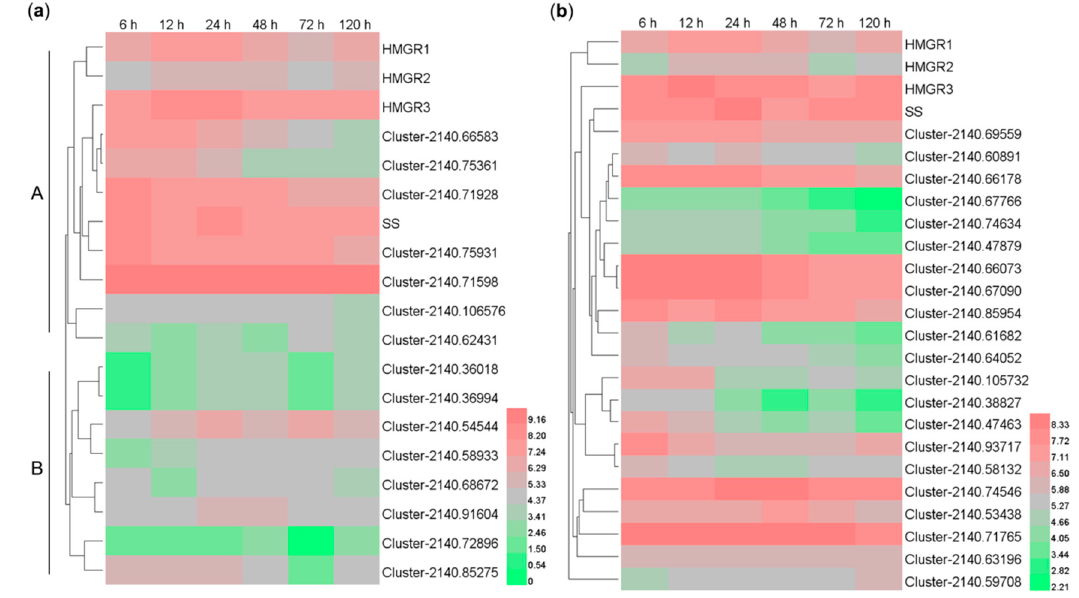
Figure 5. Gene cluster analysis of the MeJA-induced CYP450 ( a ) and UGT ( b ) unigenes with the HMGR- and SS-encoding genes across the different MeJA-treating time points.